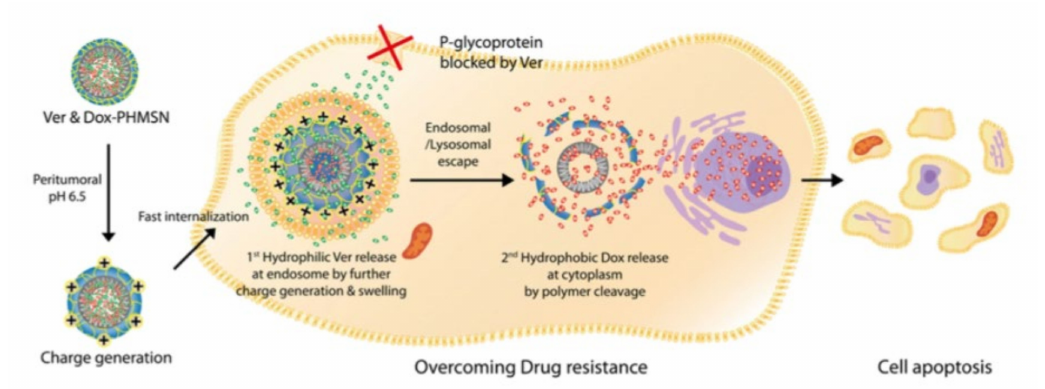
Figure 5. Sequential release of hydrophobic, hydrophilic drugs from polymer gatekeeper